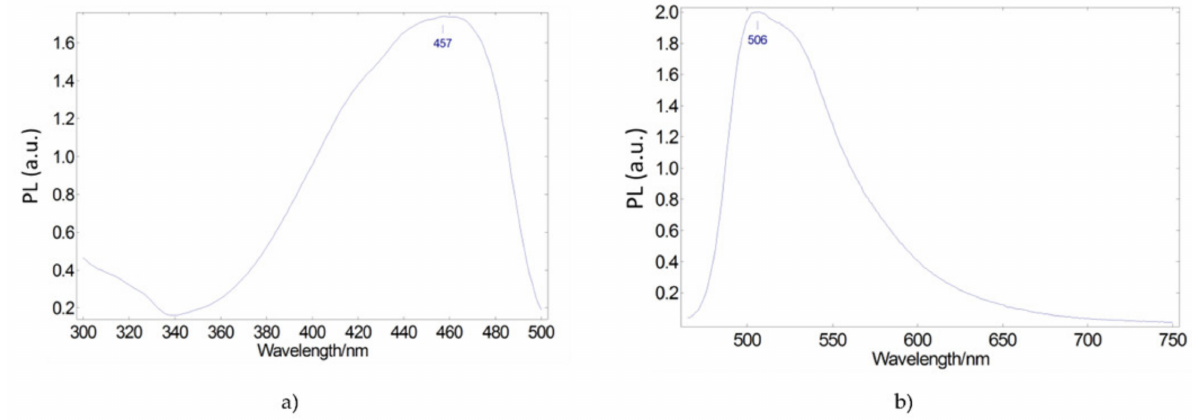
Figure 2. Photoluminescent excitation ( a ) and emission ( b ) spectra of Coumarin 6 green-emitting converter embedded in a PMMA